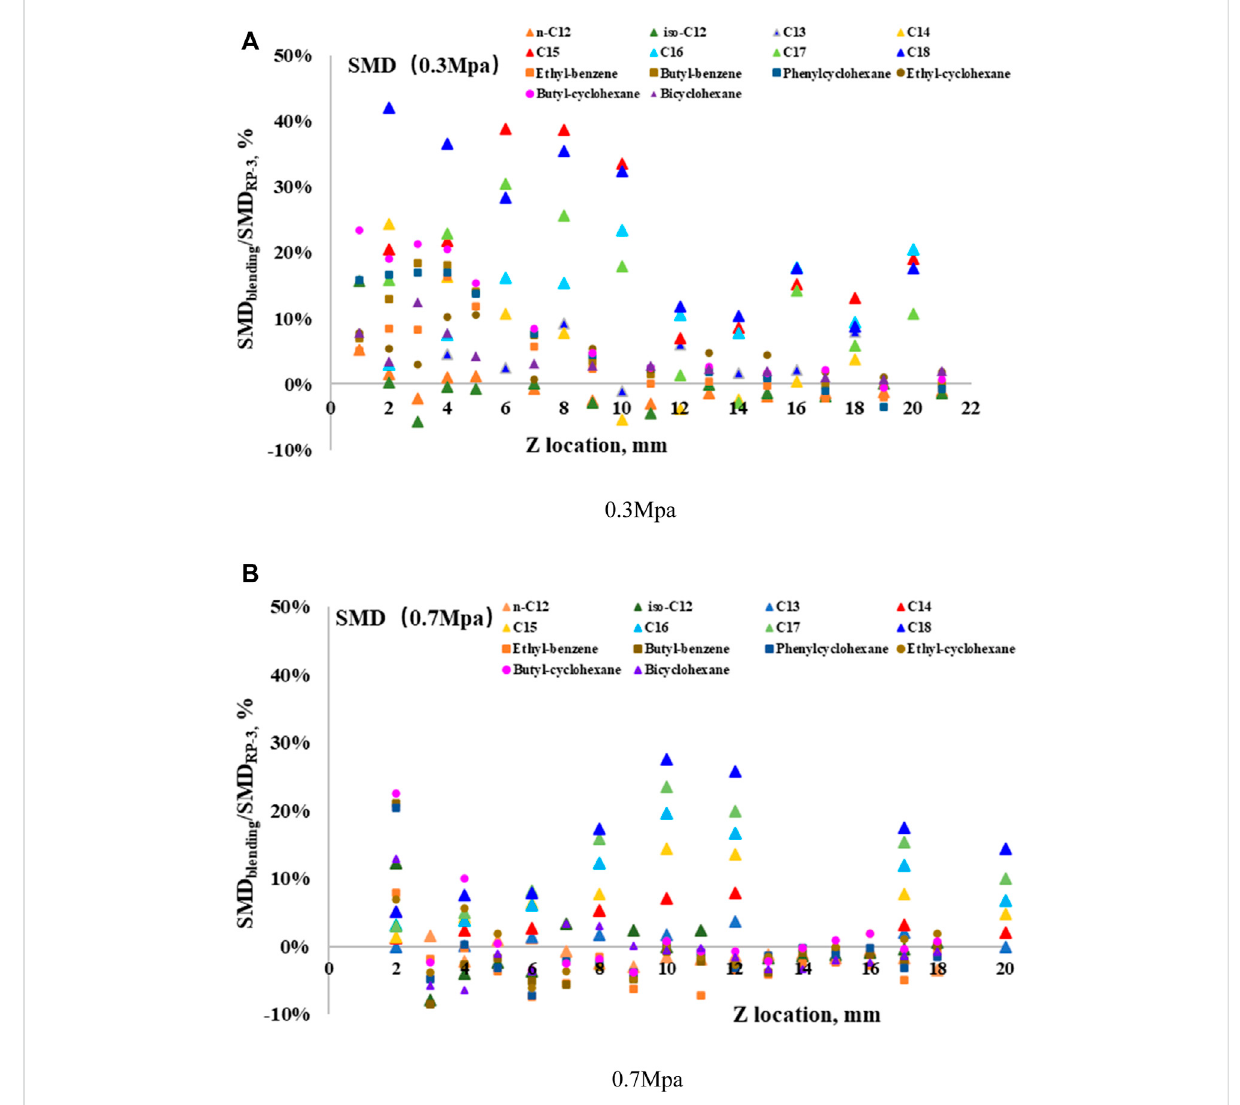
FIGURE 4 SMD distribution of blending fuel in comparison with RP-3. (A) 0.3 Mpa; (B) 0.7